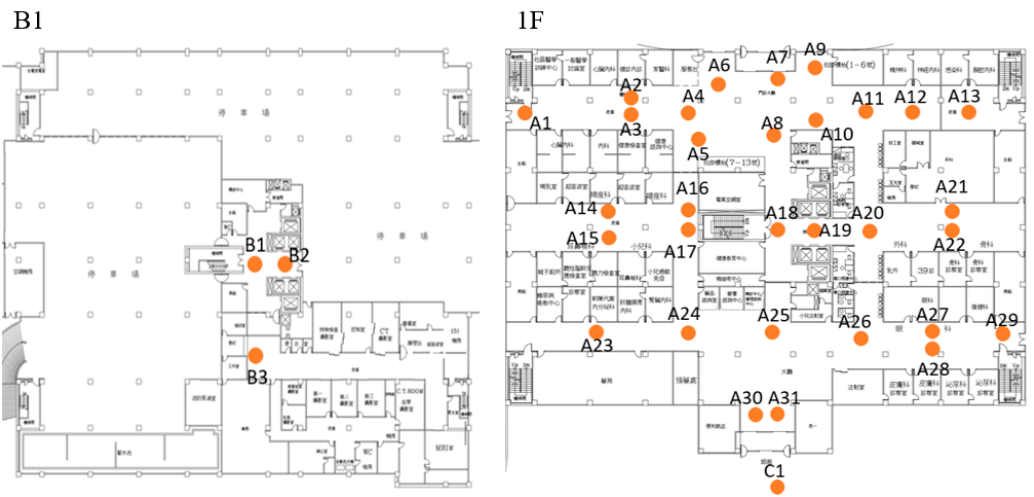
Figure 13. The deployment maps of Lbeacons in NTUH-Yunlin.